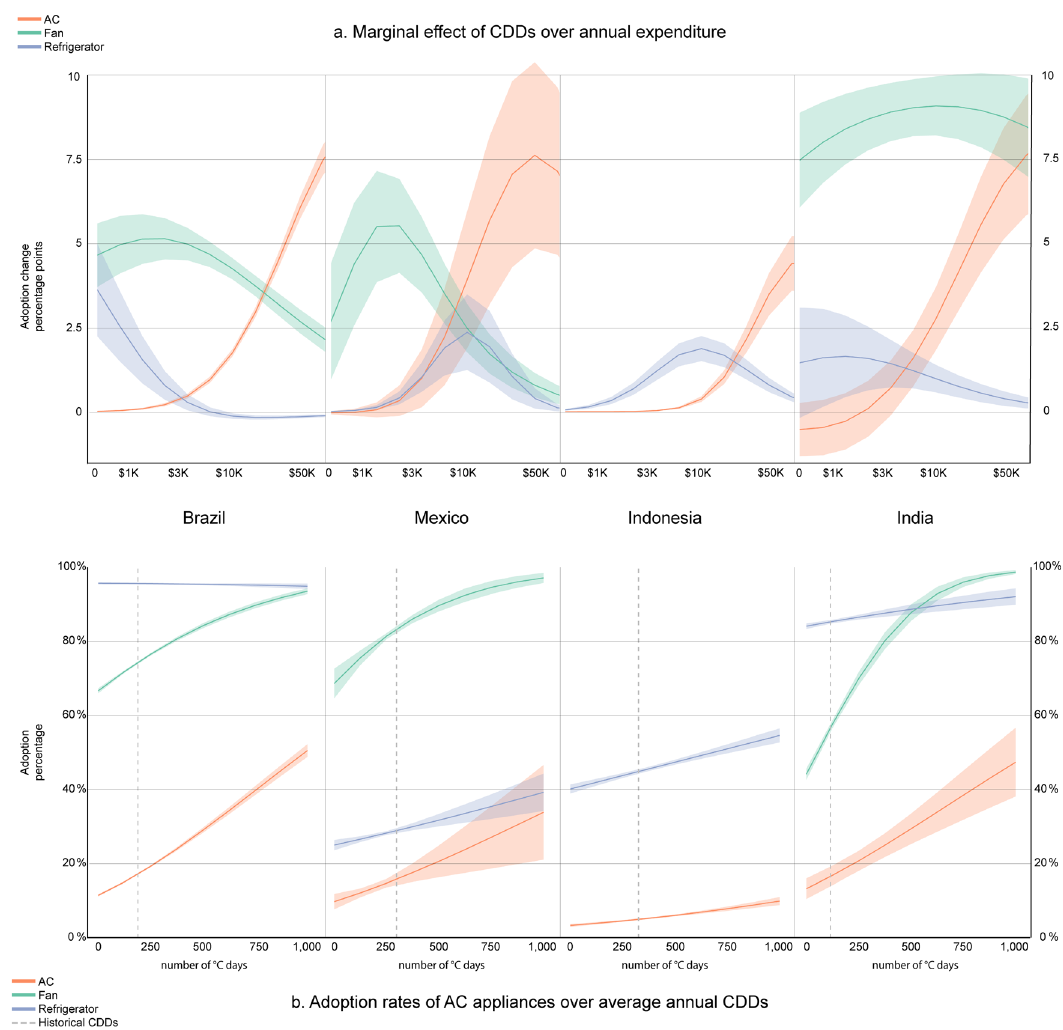
Fig. 2 Drivers of air-conditioning adoption. a Marginal elasticity of air-conditioning adoption to a one-hundred increase in CDDs across income levels. b Predicted adoption rates of AC and other cooling devices for varying CDDs wet-bulbs. All other drivers are assumed at their historical mean value (full regression results shown in Supplementary Table 5). The vertical dashed line marks the country-speci fi c, long-term historical average of CDDs. Shaded areas represent the dispersion in predicted adoption levels across